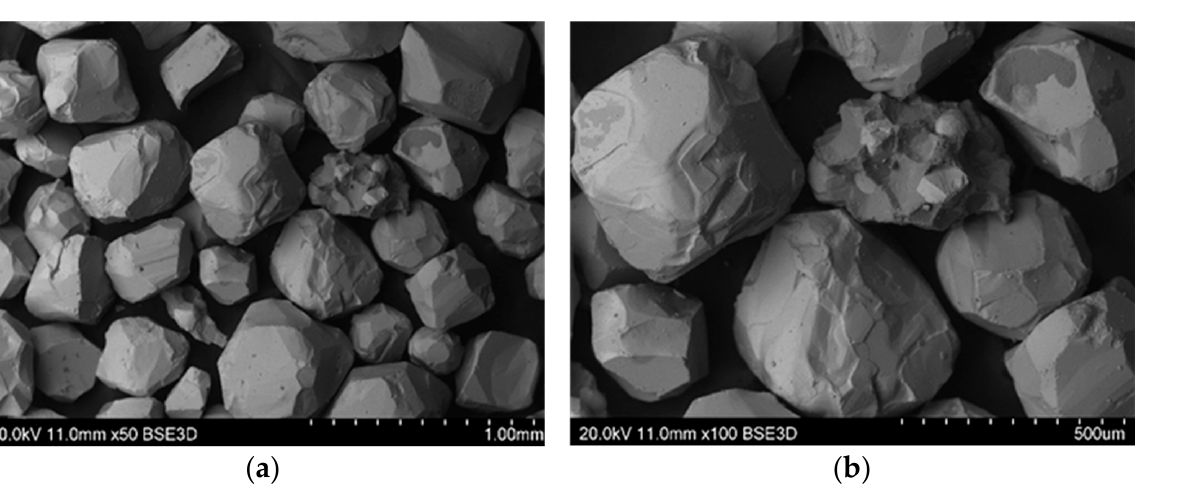
( b ) Figure 16. BSD images from the scanning electron microscope of the used sand on the R100 chromite matrix: ( a ) mag. 50×, ( b ) mag. 100×. ( a ) ( b ) Figure 17. BSD images from the scanning electron microscope of mechanical reclaimed material after 5 min of treatment of the used sand on the RM5M100 chromite matrix: ( a ) mag. 50×, ( b ) mag 100×.